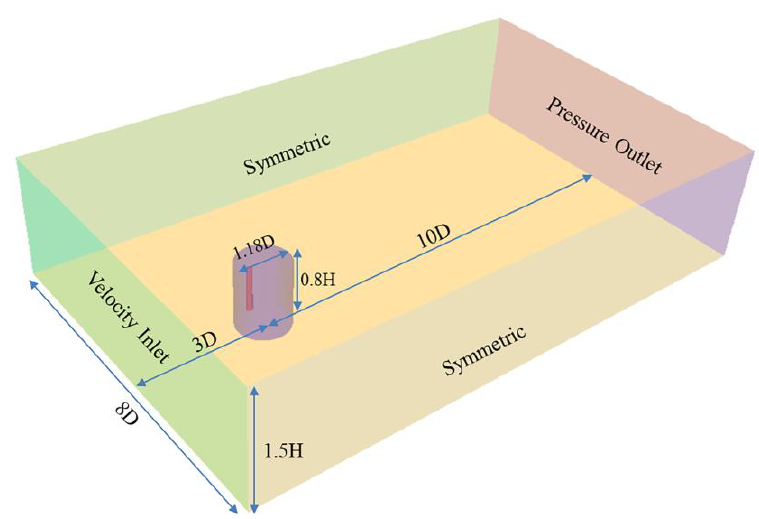
Figure 3. Computational domain with boundary conditions and sizes.